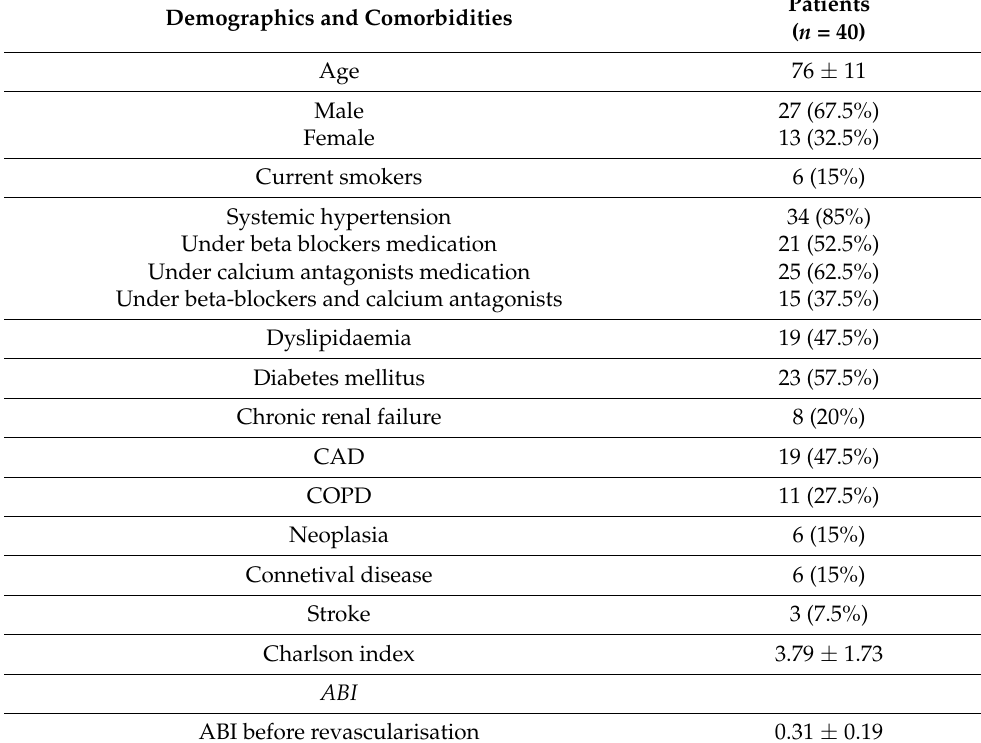
Table 1. Demographic data,